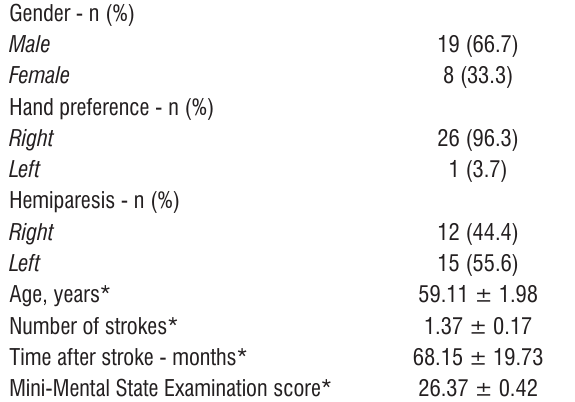
Table 1 - Characterization of the